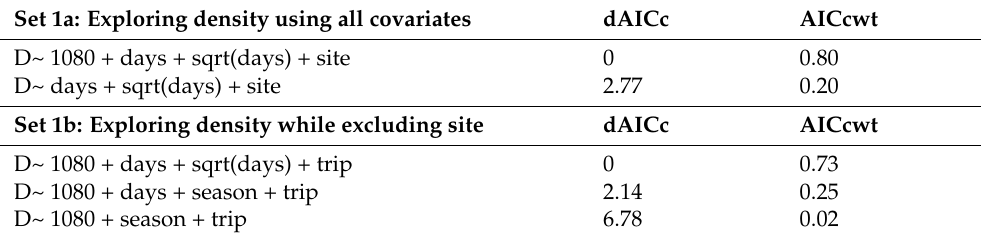
Table 1. Summary of model set 1 (all models with dAICc < 10).